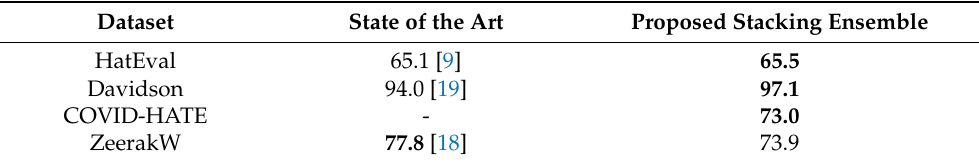
Table 13. F1-score (%) of the state-of-the-art and the proposed stacking ensemble on all datasets. Bold entries show the highest performance for each